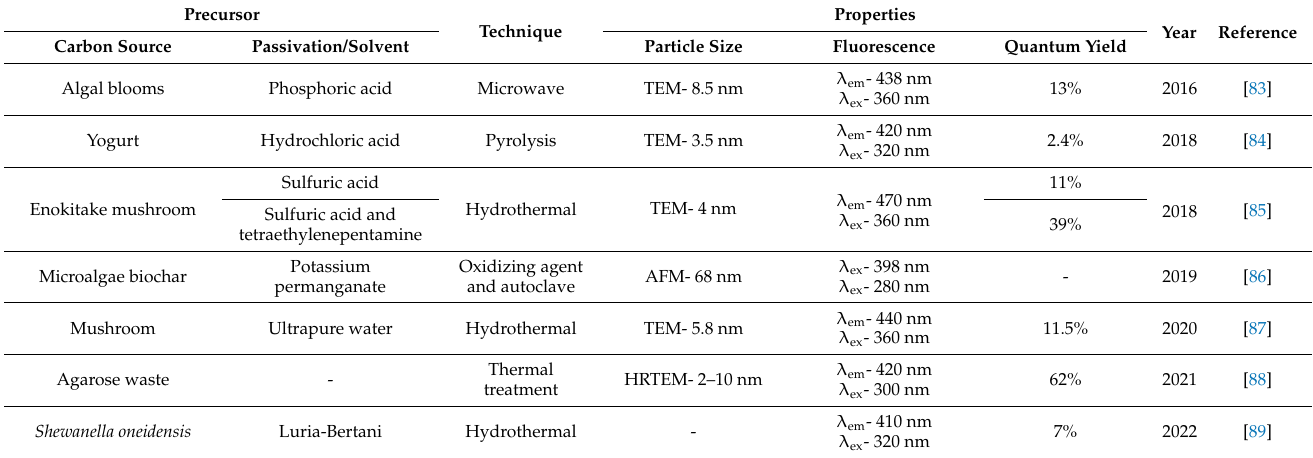
Table 6. Summary of the synthesis of CDs from fungi/bacteria